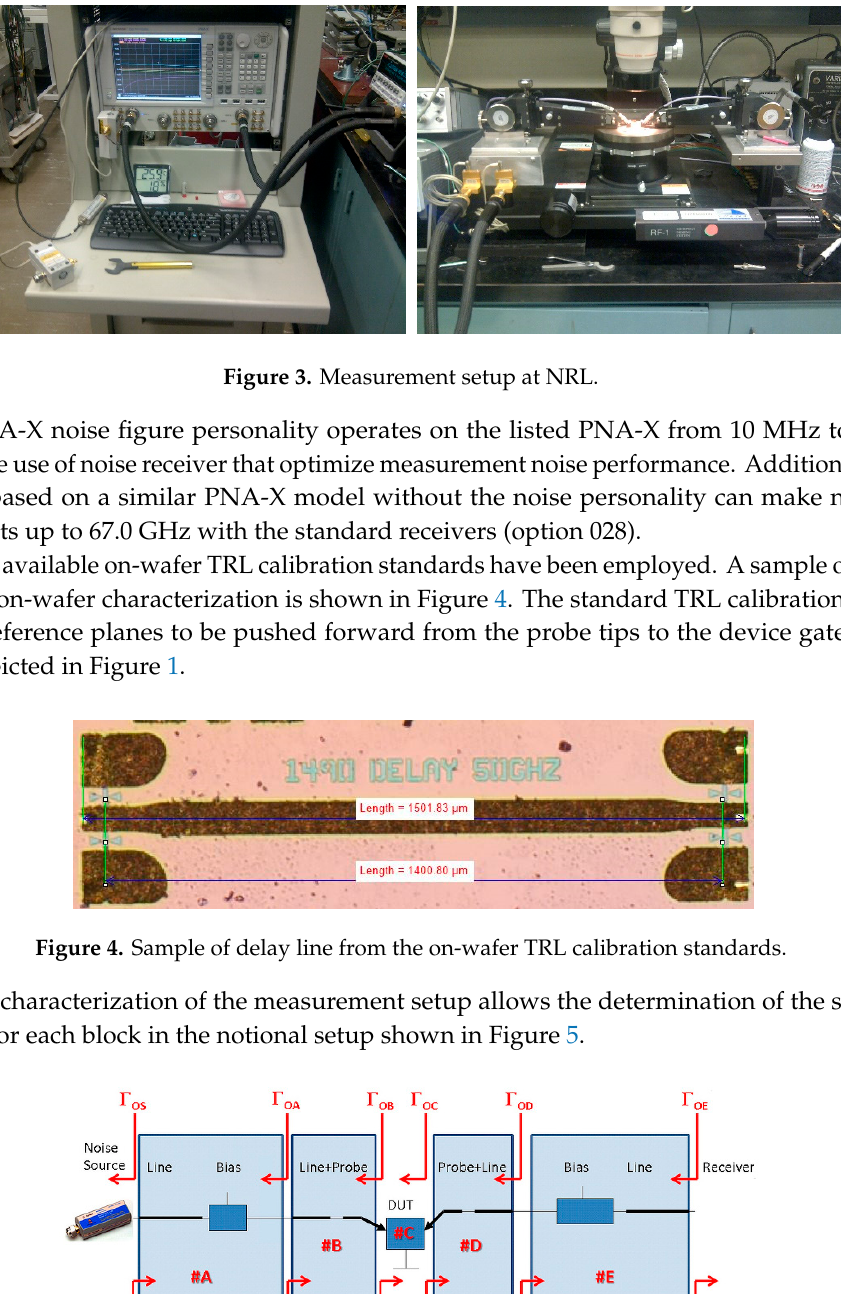
Figure 5. Notional measurement setup at NRL.